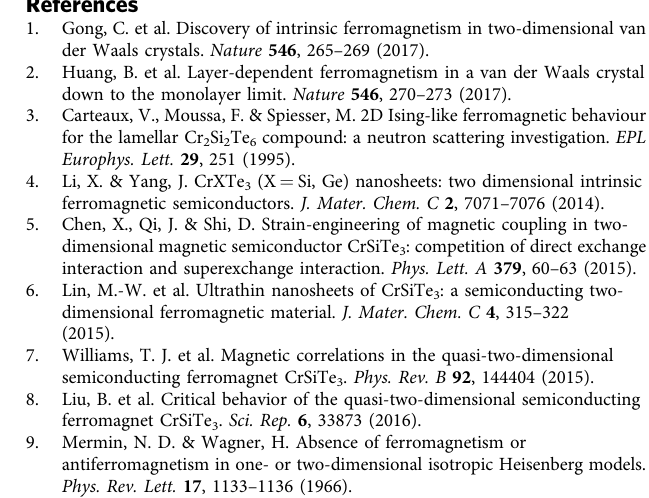
Fig. 4 Hyper-polarizable bond model and dimensional crossover. Plots show hyper-polarizable bond model calculations of the change in each of the eight allowed SHG susceptibility tensor elements relative to their undistorted values ( Δ χ normal coordinates. Schematics in the insets show the bonds (springs) used in our model and depict how each distortion is parameterized. Both d , A 4 g vertical and horizontal axes are plotted on a linear scale. Tensor elements that change in the same way are represented as multi-colored curves. e Illustration of the spin ordering process in CrSiTe 3 deduced from our data. The light blue regions represent an absence of spin-spin correlations and the dark blue regions represent FM correlations, which are dynamic above T c and static below T